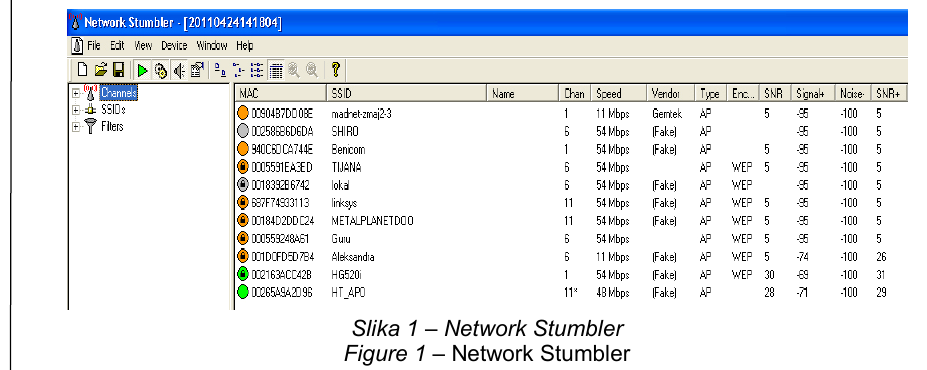
Figure 1 – Network